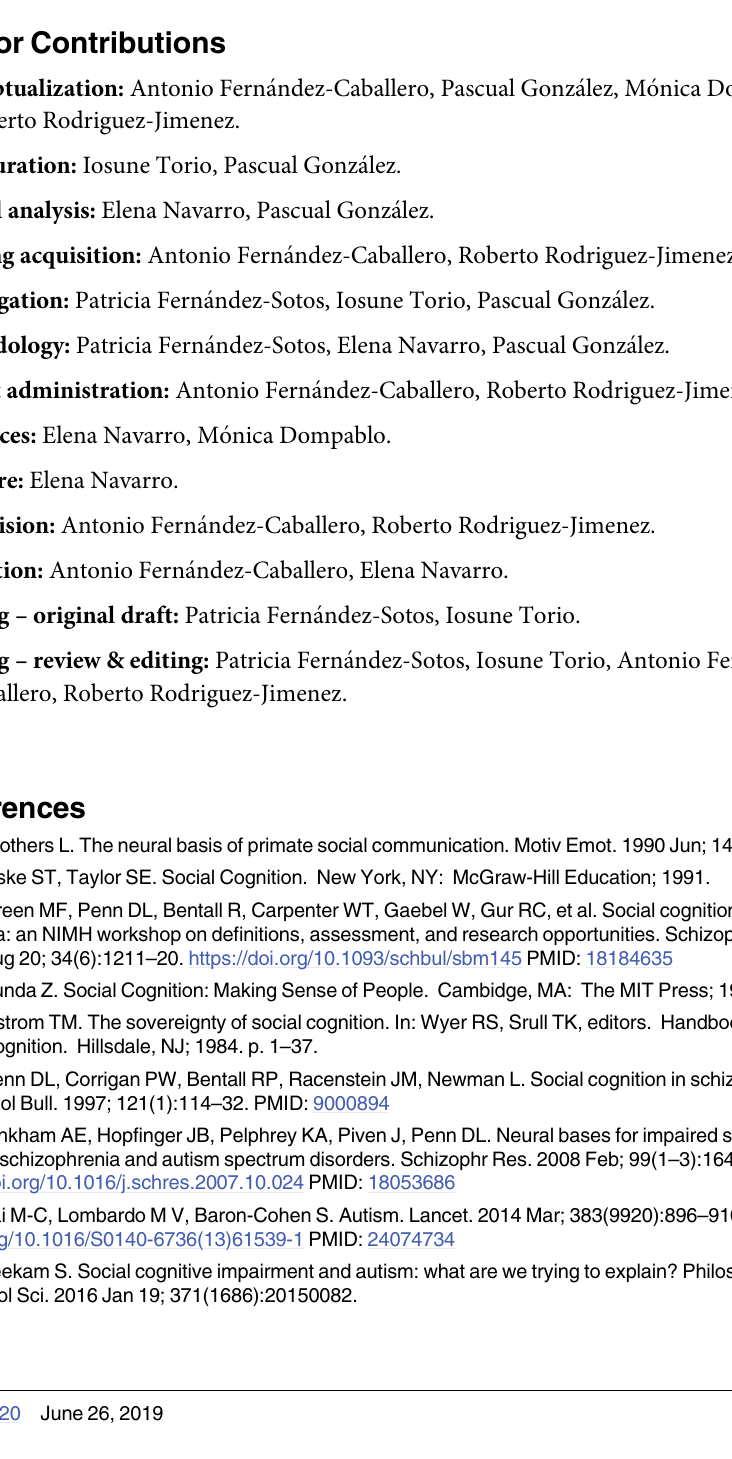
S2 Table. Publication venues. S3 Table. Cognitive rehabilitation